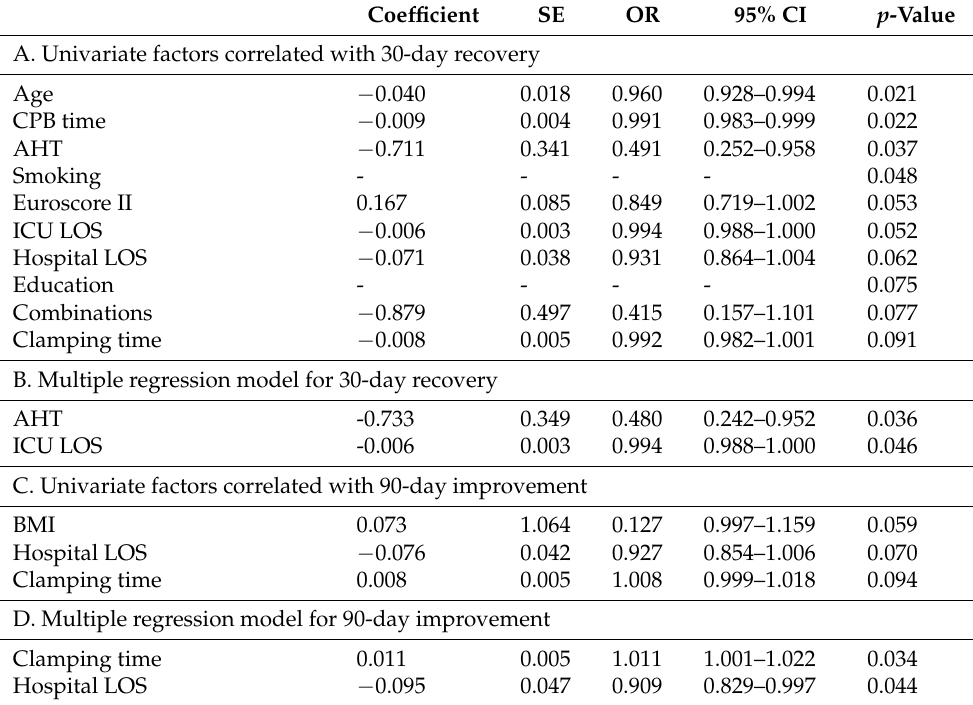
Table 3. Results of the univariate and multivariate logistic regression analyses for good QoR at 30 days and 90 days